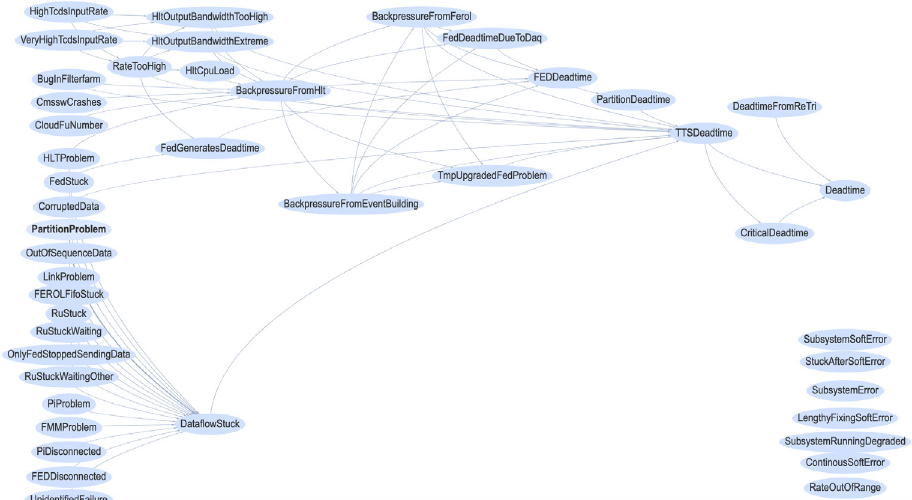
Fig. 3. Causality graph of the Logic Modules (partial). Conditions on the right hand side may be the symptom of conditions on the left hand